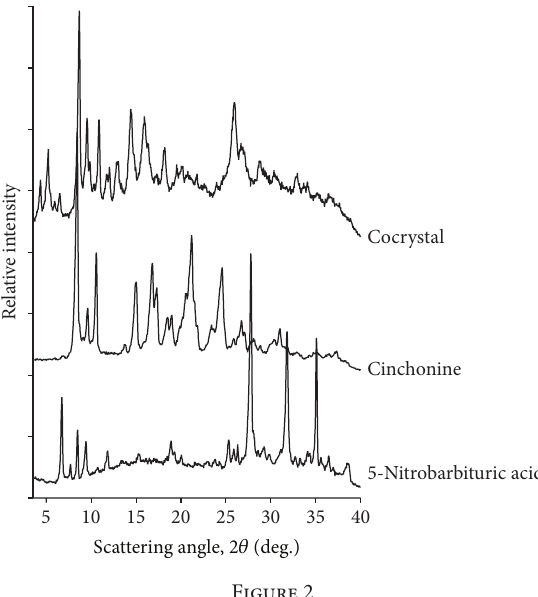
Figure 3: X-ray powder diffraction patterns of 5-nitrobarbituric acid, cinchonine, and the 1: 1 nitrobarbituric-cinchonine